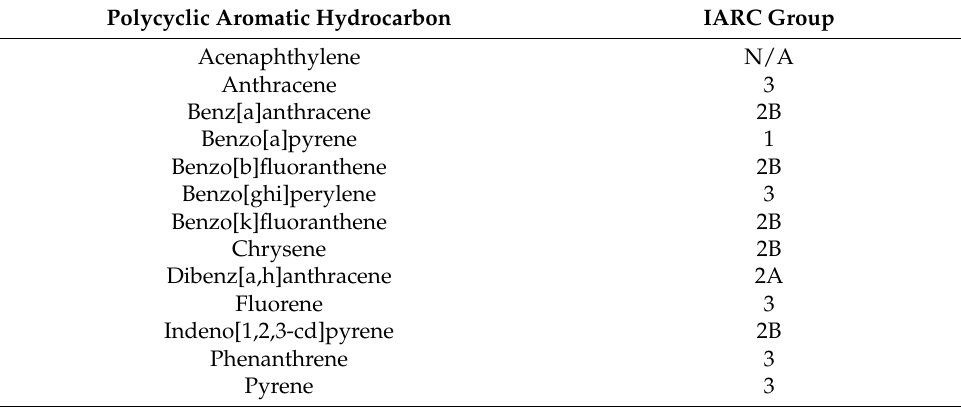
Table 1. IARC groups of polycyclic aromatic hydrocarbons are investigated in this study. Group 1: carcinogenic; group 2A: probably carcinogenic; group 2B: possibly carcinogenic; group 3: not classifiable; N/A: no information